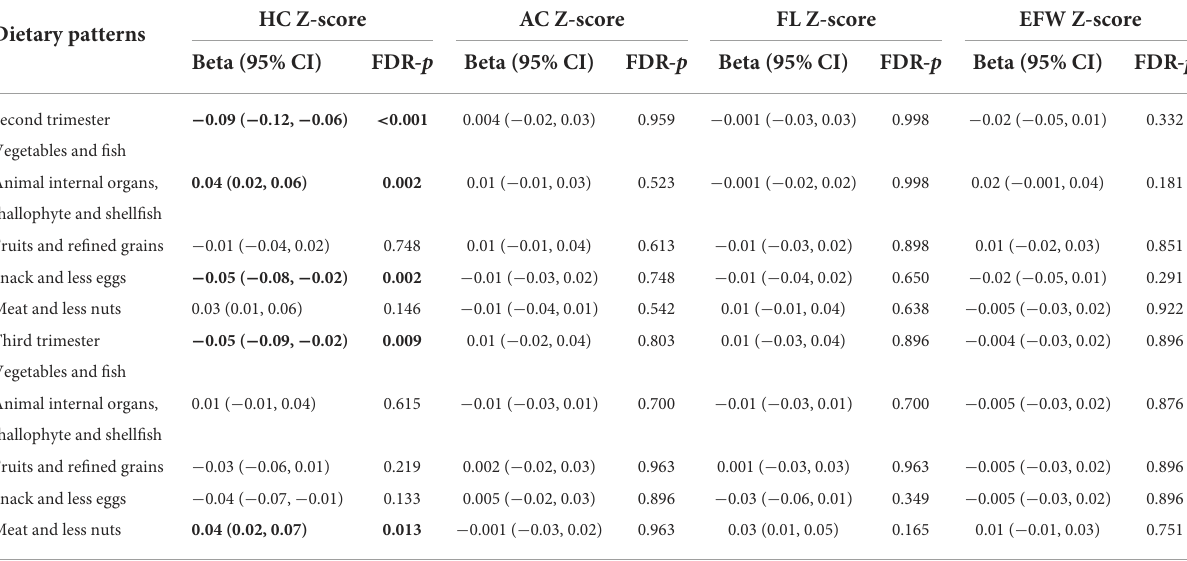
TABLE 2 Adjusted associations of maternal dietary patterns in the second and third trimester of pregnancy with fetal growth indicators. Dietary